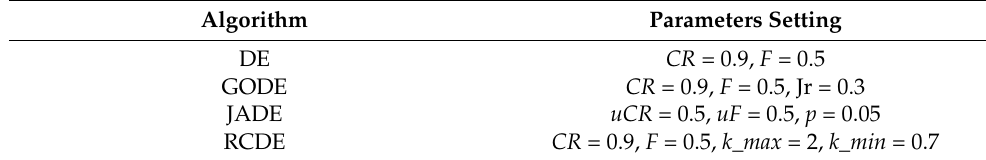
Table 3. Parameter settings for the four